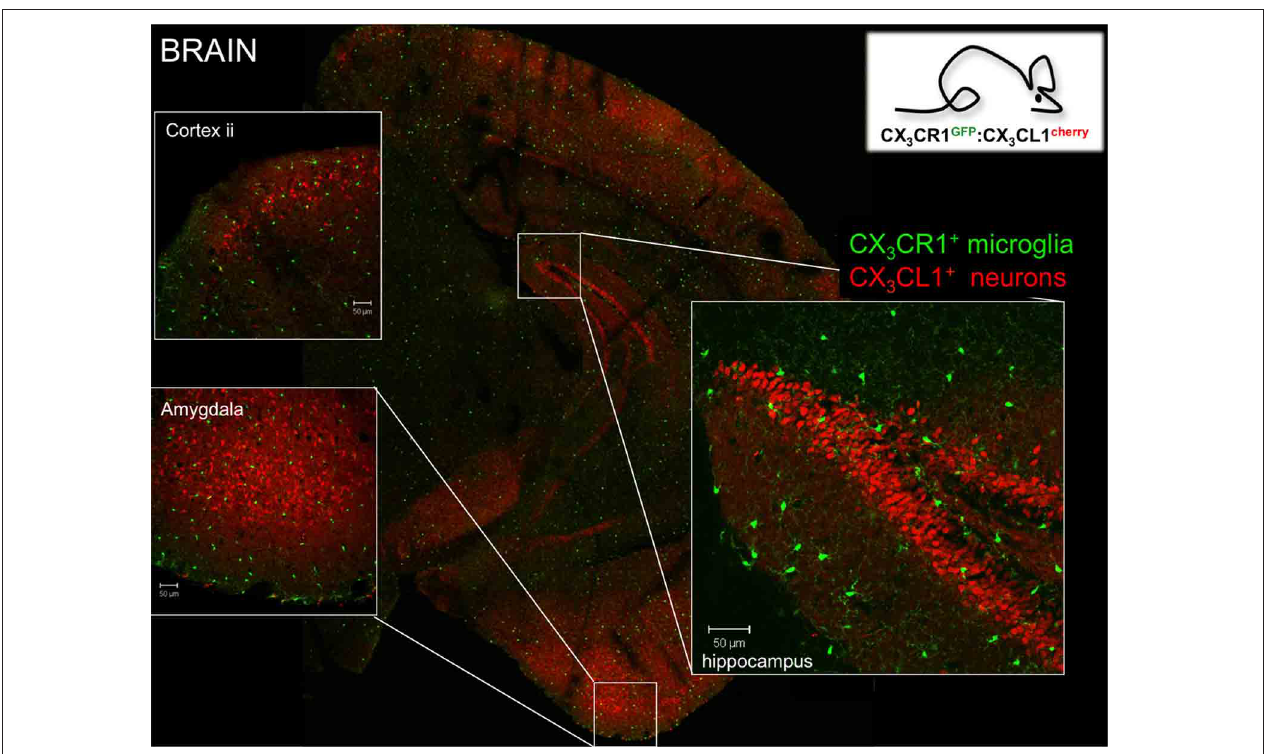
reporters are expressed in the cytoplasm and not as fusion proteins. Thus they reflect the respective promoter activity but not the presence of the respective proteins. Hence no co-localization has to be